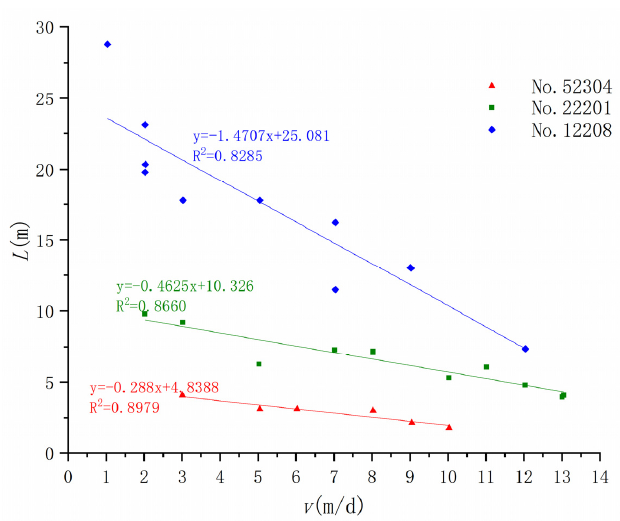
Figure 9. Relationship between ground fissure advance rate v and horizontal distance L .